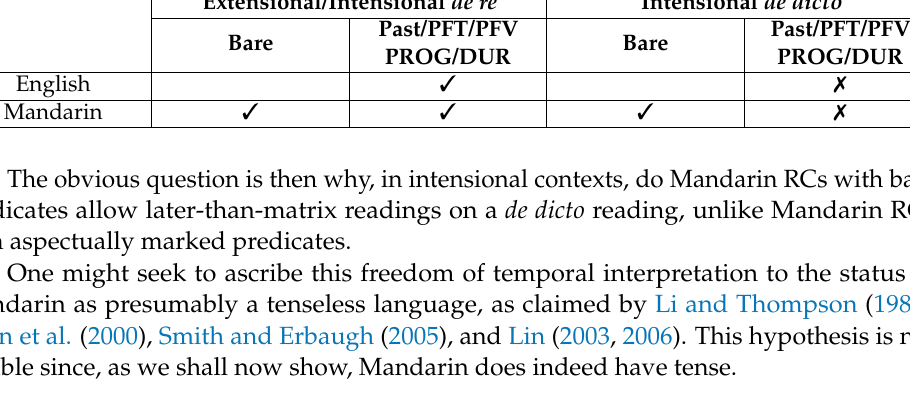
Table 1. Availability of later-than-matrix readings. Extensional/Intensional de